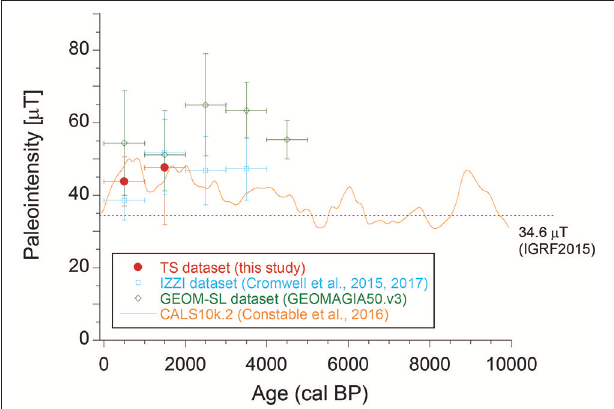
FIGURE 9 | Holocene paleointensity variation in Hawaii in terms of the 1,000-year bins by the TS dataset (red circles), the IZZI dataset (blue squares), and the GEOM-SL dataset (green diamonds). Data points are shown if each point is associated with not < 3 site-mean paleointensities. Vertical error bars indicate one standard deviations. The CALS10k.2 model ( Constable et al., 2016) is also indicated for